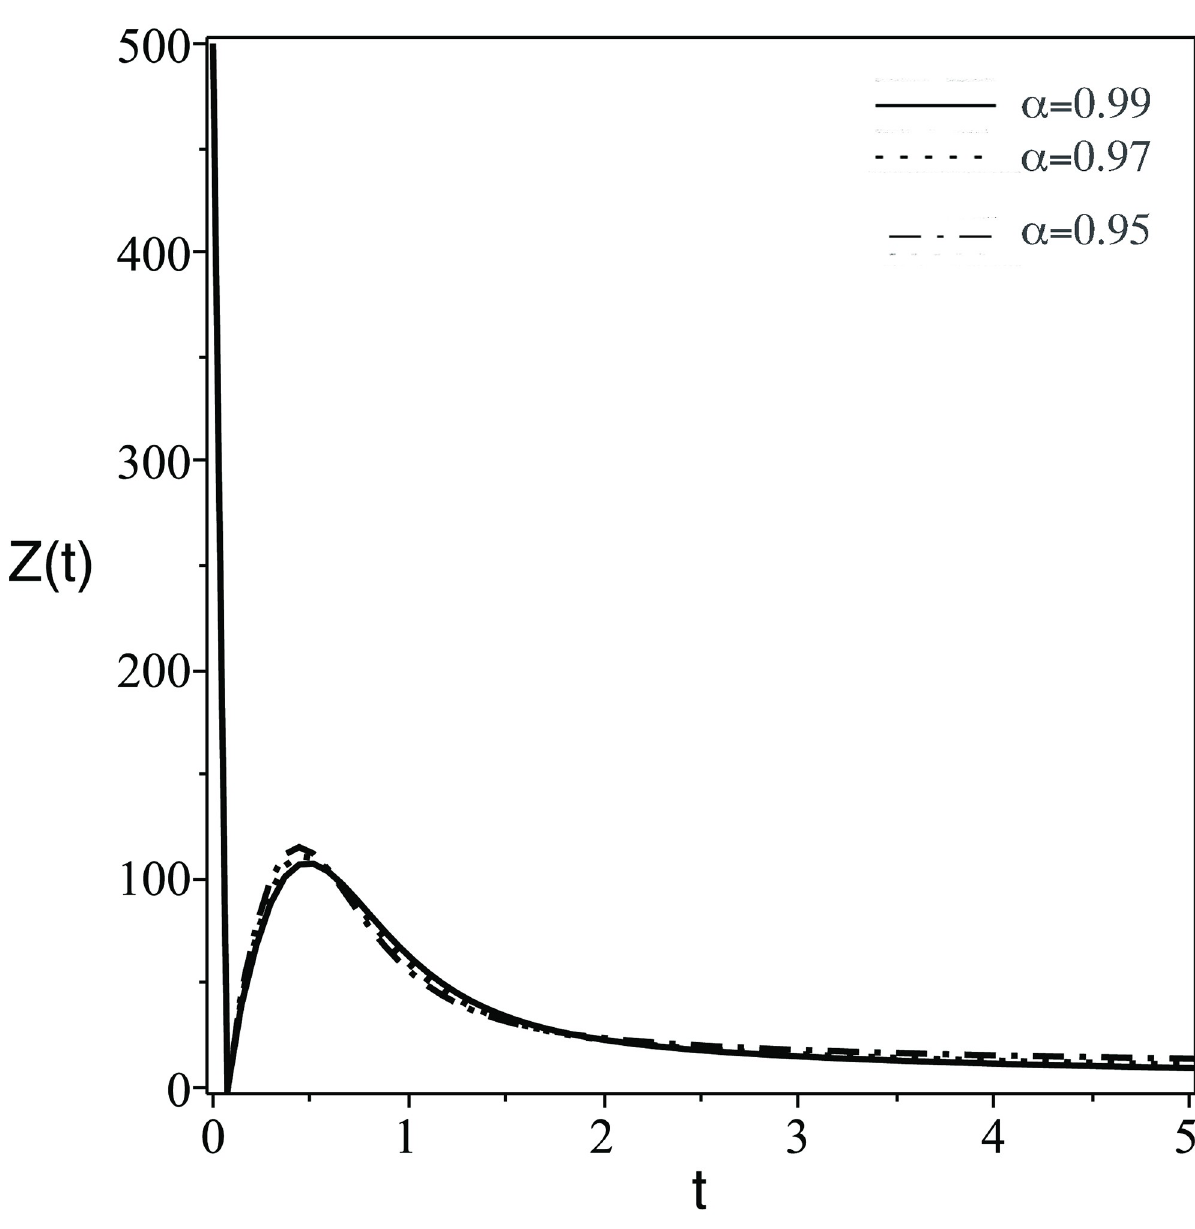
Fig 5. Same as Fig 1 but for the number of immune system cells (CD8 + T cells), Z ( t